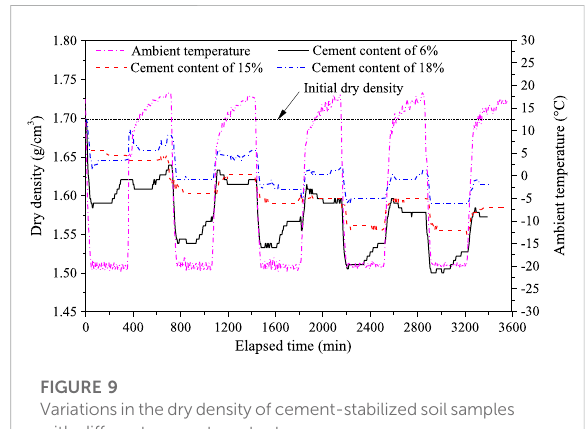
FIGURE 8 Variations in the deformation of cement-stabilized soil samples with different cement contents.